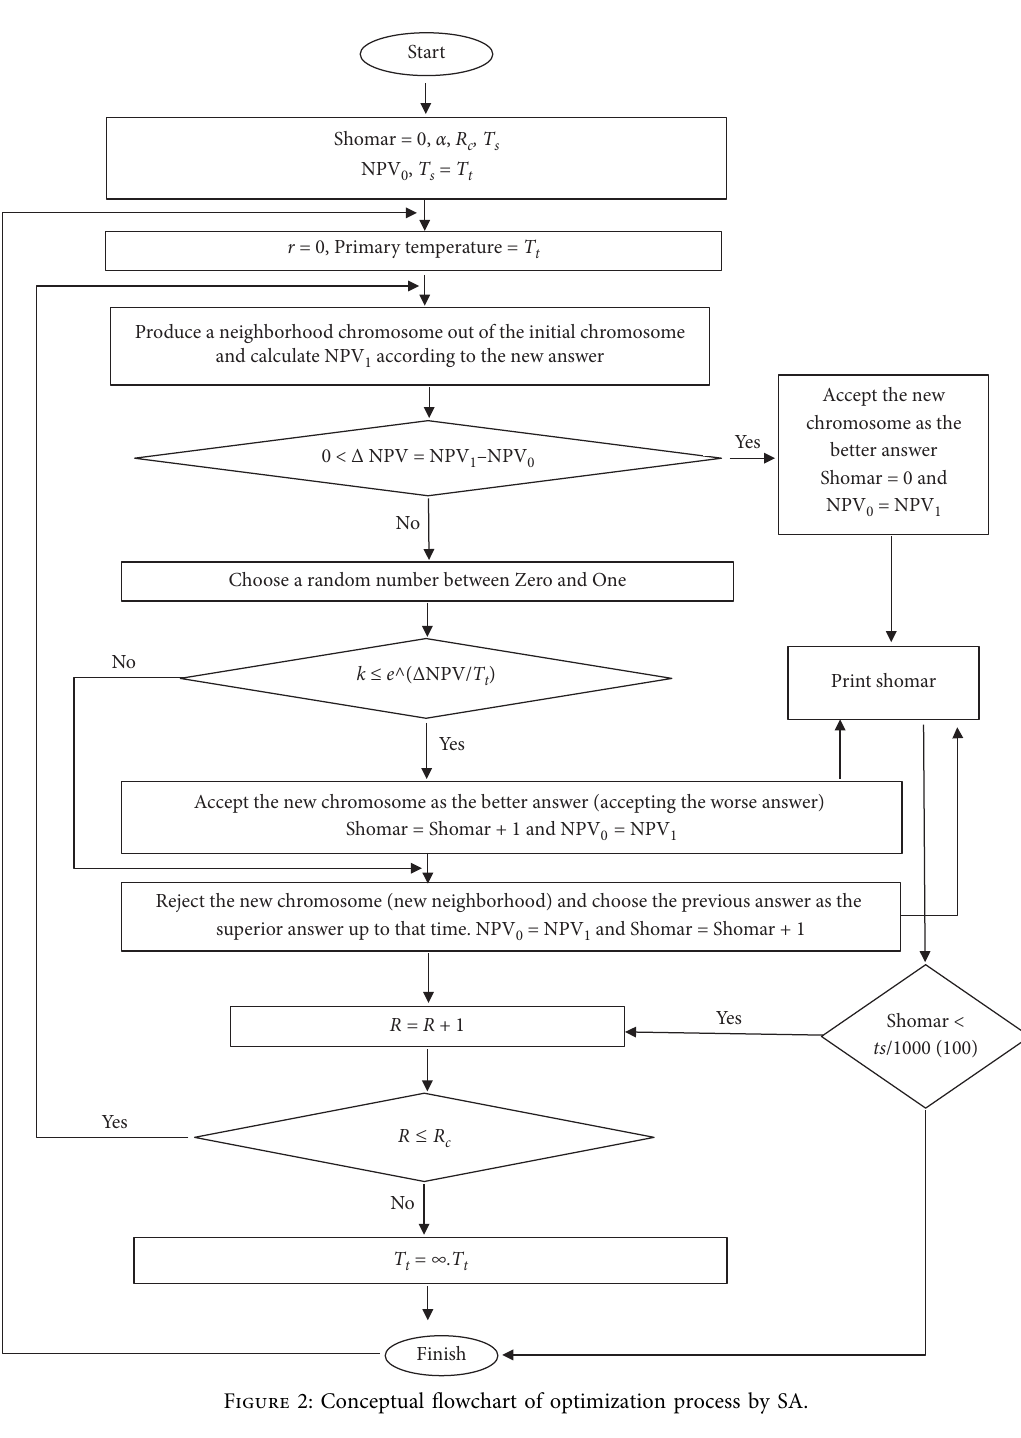
Figure 2: Conceptual flowchart of optimization process by